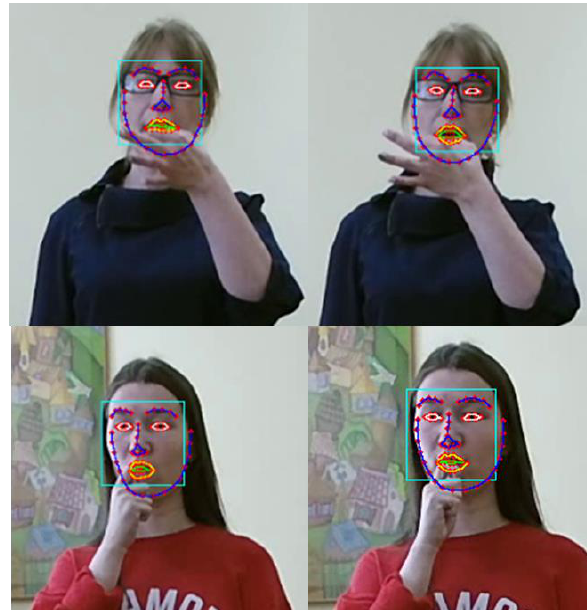
Figure 4. An examples of overlap effect in Russian sign language